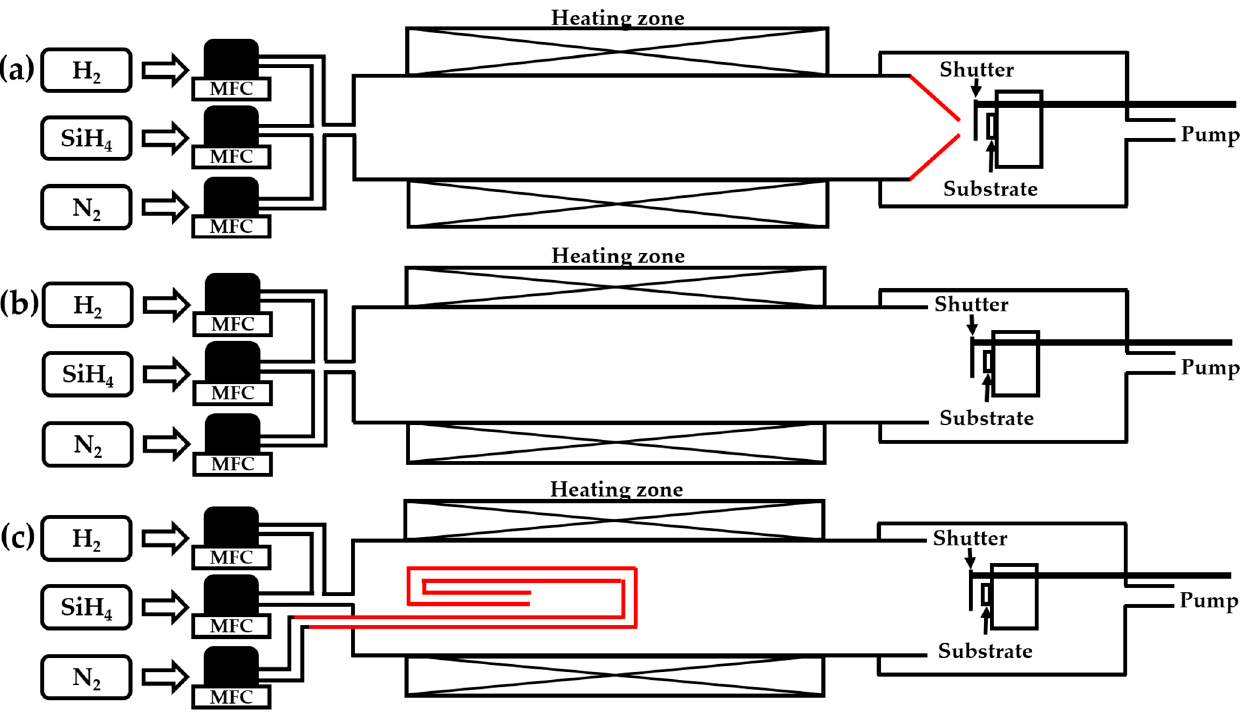
Figure 1. Schematics of the experimental setup for the deposition of silicon oxide using a cylindrical quartz tube with ( a ) a conical nozzle, ( b ) without a conical nozzle, and ( c ) with a stainless tube for preheating of N 2 .